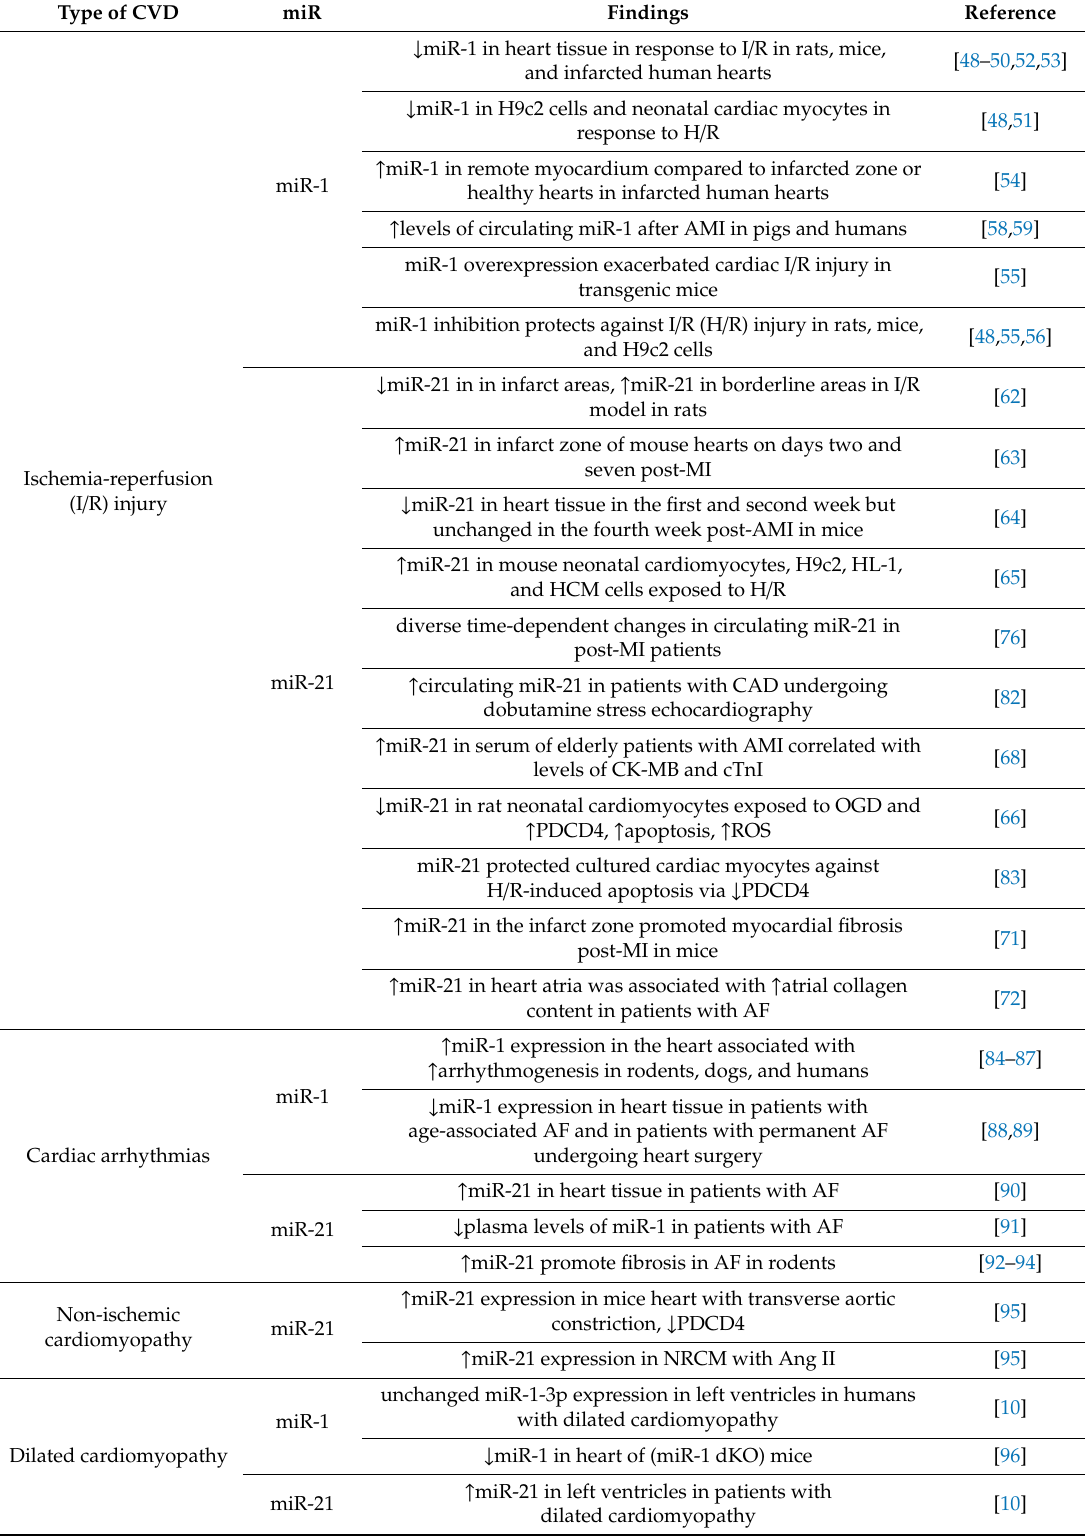
Table 1. Role of miR-1 and miR-21 in di ff erent types of